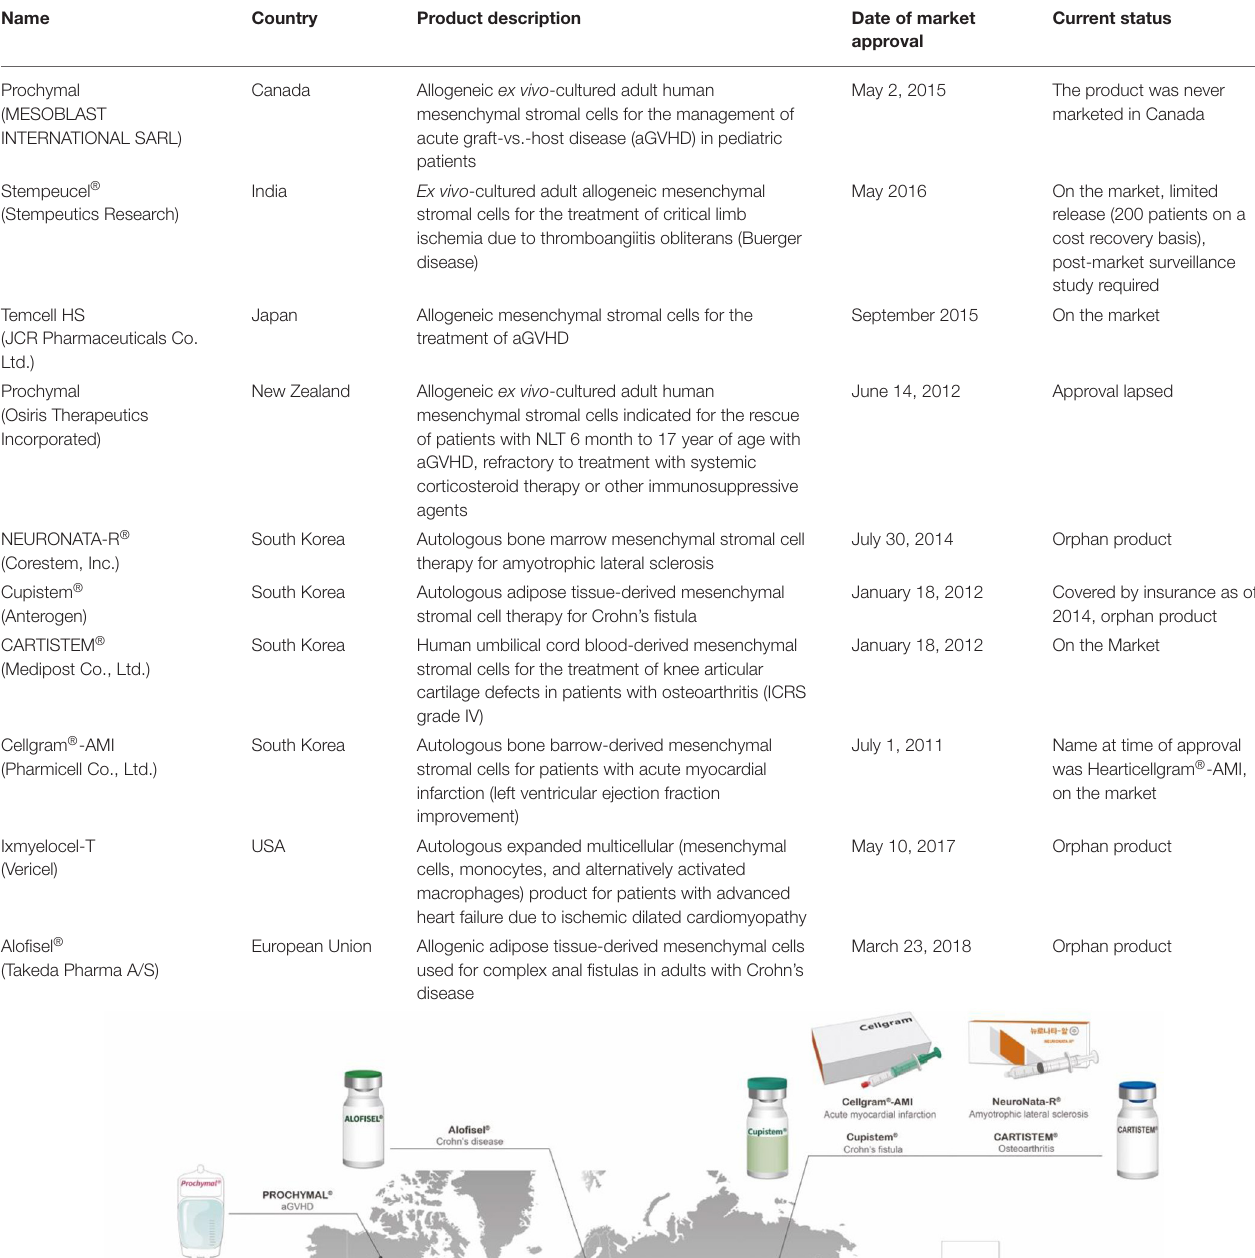
TABLE 1 | A list of approved cell therapy products around the world and a graphical image of countries where MSC therapies are approved and clinically